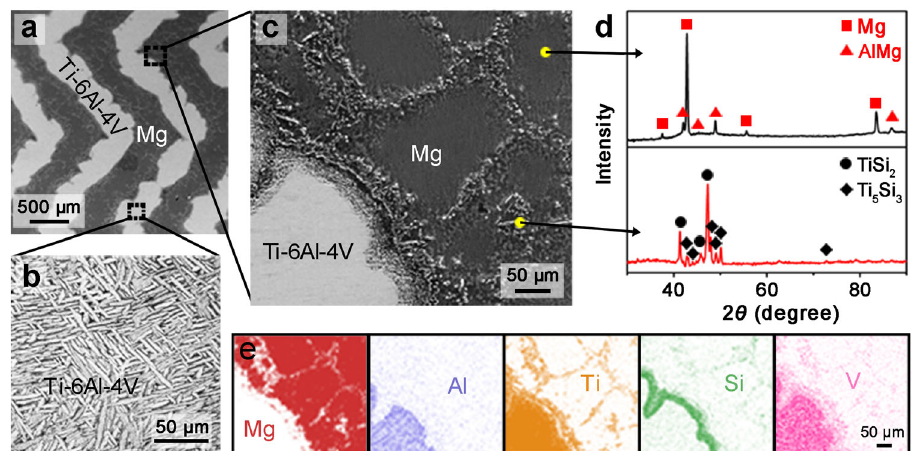
Fig. 2 Fine microstructures, phase constitutions, and element distributions in bioinspired Mg-Ti composites. a – c Micrographs of a the Mg-Ti composite, b the Ti-6Al-4V reinforcement, and c the Mg matrix along with the interfacial region between Mg and Ti-6Al-4V phases. d Microzone XRD patterns of the Mg matrix within the grains (upper) and at the grain boundaries (lower). e Area distributions of the elemental Mg, Al, Ti, Si, and V obtained by EDS measurement in the region corresponding to the image in c .